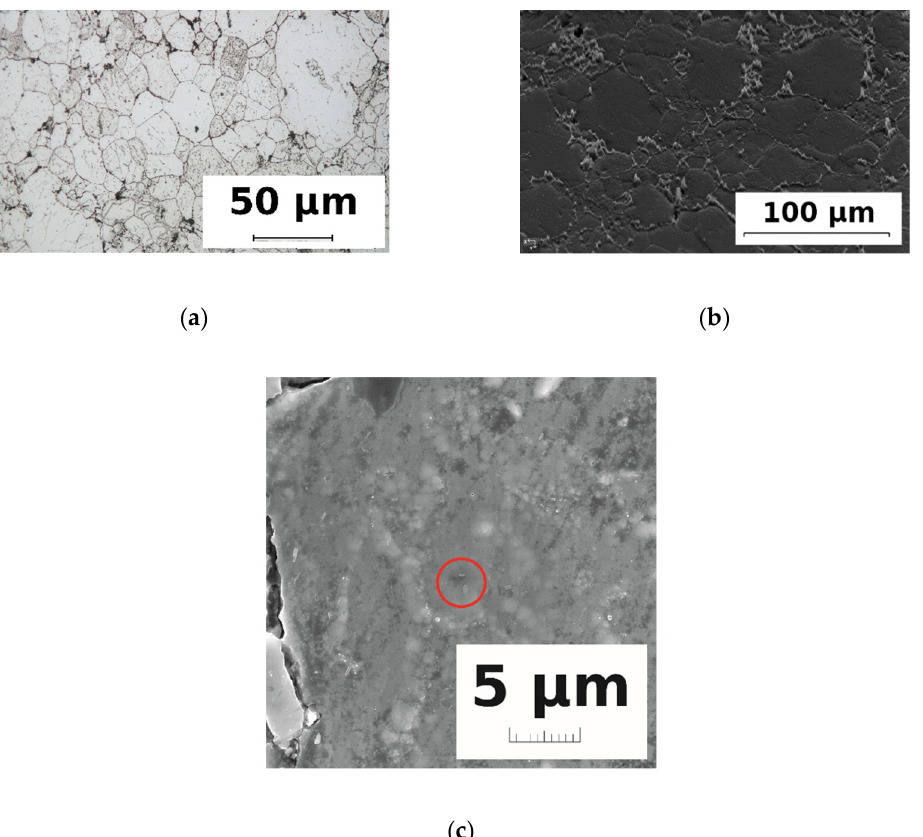
Figure 1. Microstructure of SPSed AA7075: transverse cross-sectional LM micrograph of etched microstructure ( a ); transverse cross-sectional SEM micrographs of unetched microstructure ( b , c ). Red circle shows nanoindentation imprint.